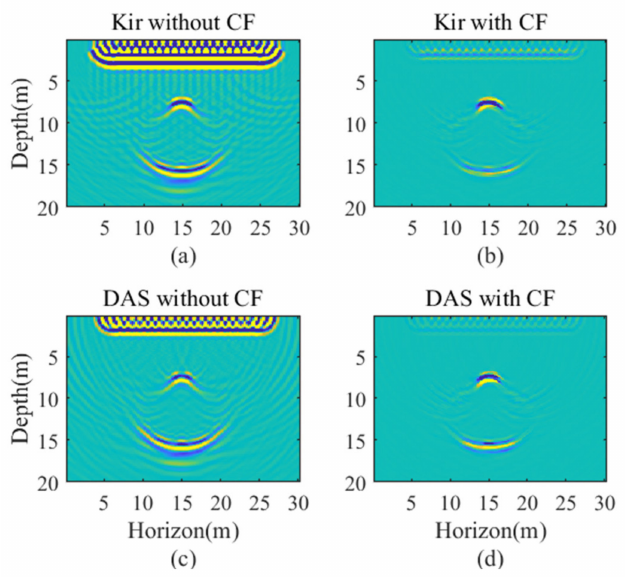
Figure 27. Results when the CF matrix was applied into Kirchhoff migration and DAS beamforming. Kirchhoff migration ( a ) without and ( b ) with CF matrix applied. DAS beamforming ( c ) without and ( d ) with CF matrix